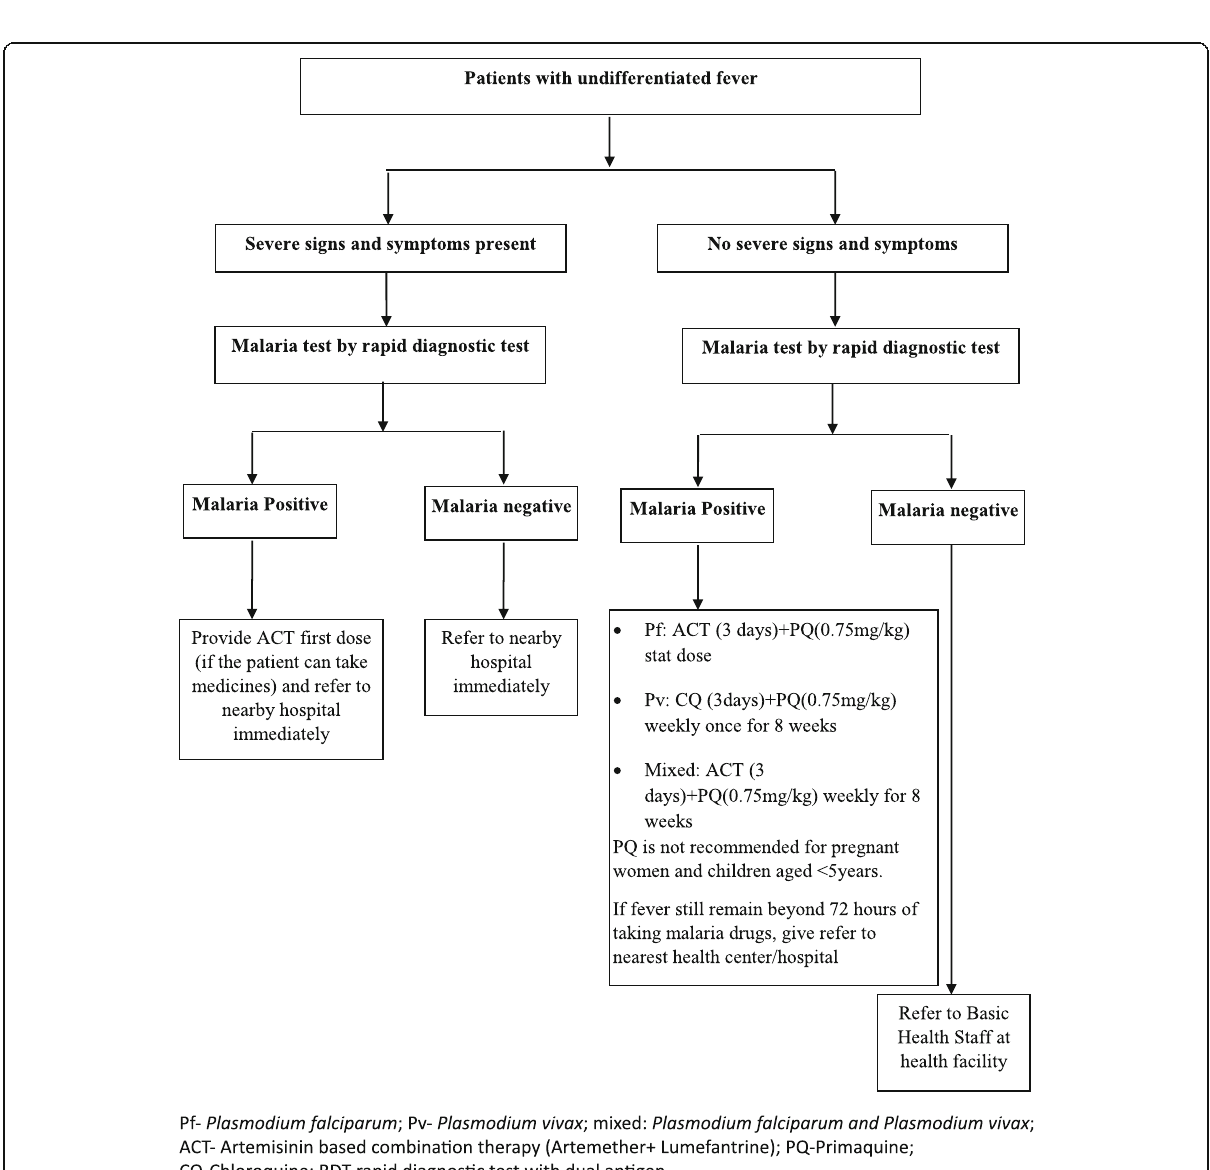
Fig. 1 Malaria testing, diagnosis, and treatment services provided by village health volunteer in Myanmar,